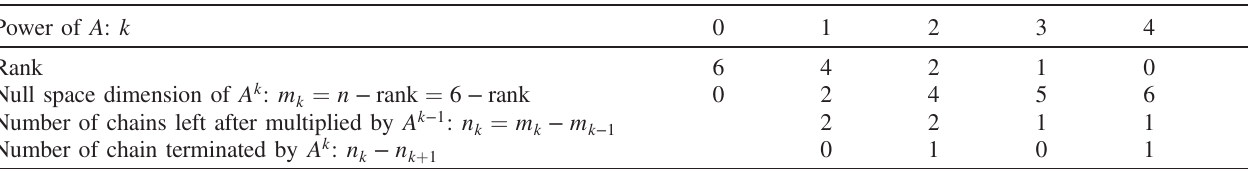
TABLE I. The ranks of the powers of a matrix A used to calculate null space size and chain structure. Power of A : k 0 1 2 3 4 5 Rank 6 4 2 1 0